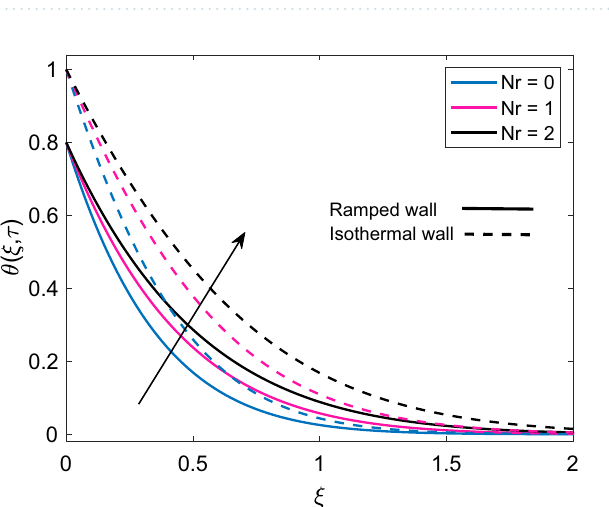
Figure 2. Comparison of temperature profile [Eq. (31)] of different nanofluids when Nr = 0.5 , φ = 0.1 and Q = 0.5 .